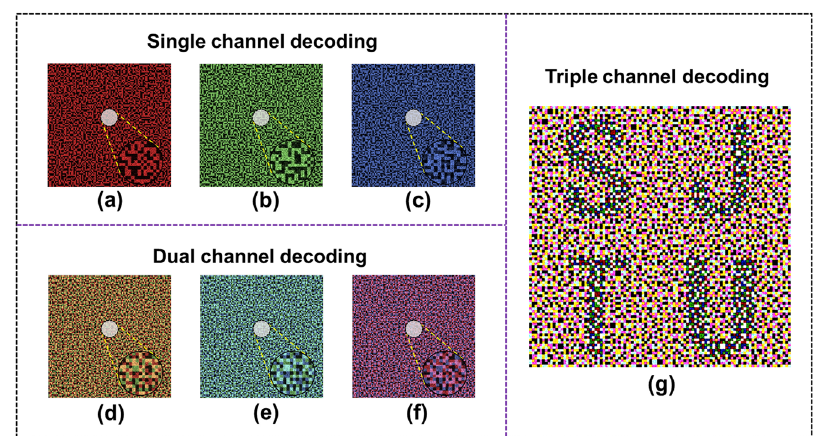
Figure 7: Simulated intensity patterns